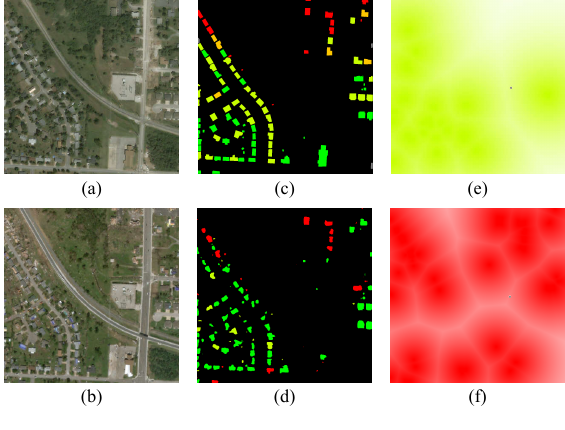
Figure 1. Results of our